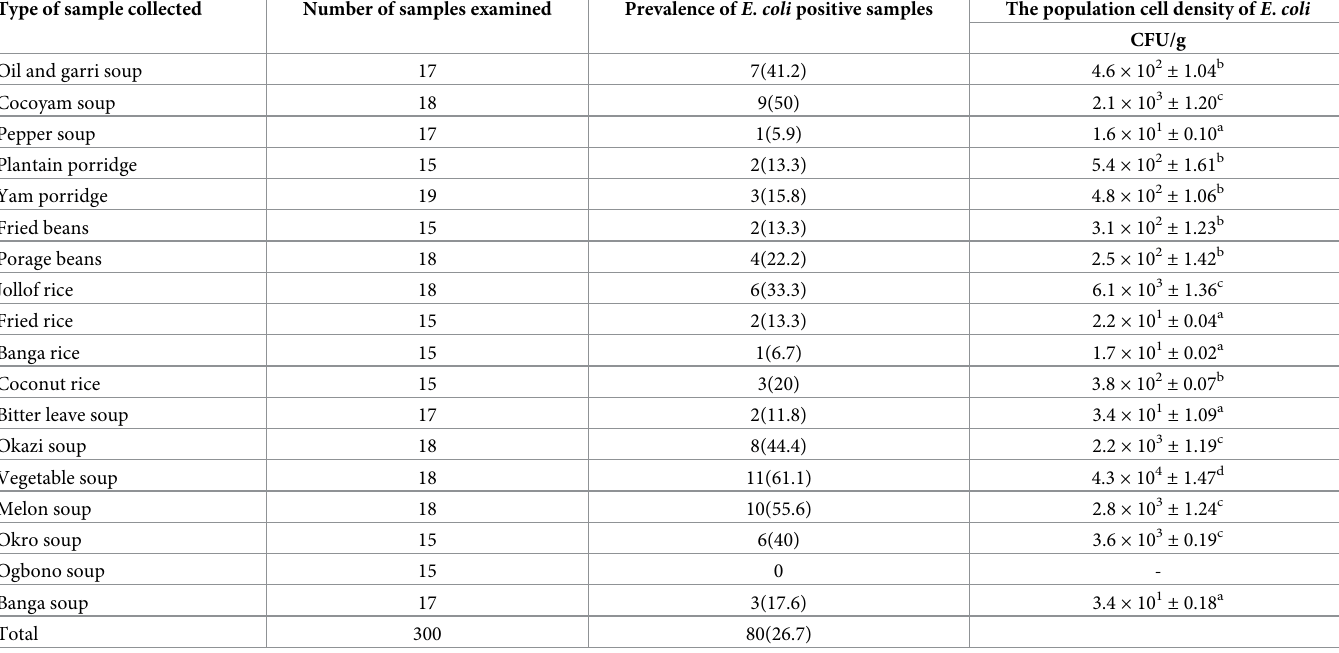
Table 1. Prevalence and E . coli counts from RTE